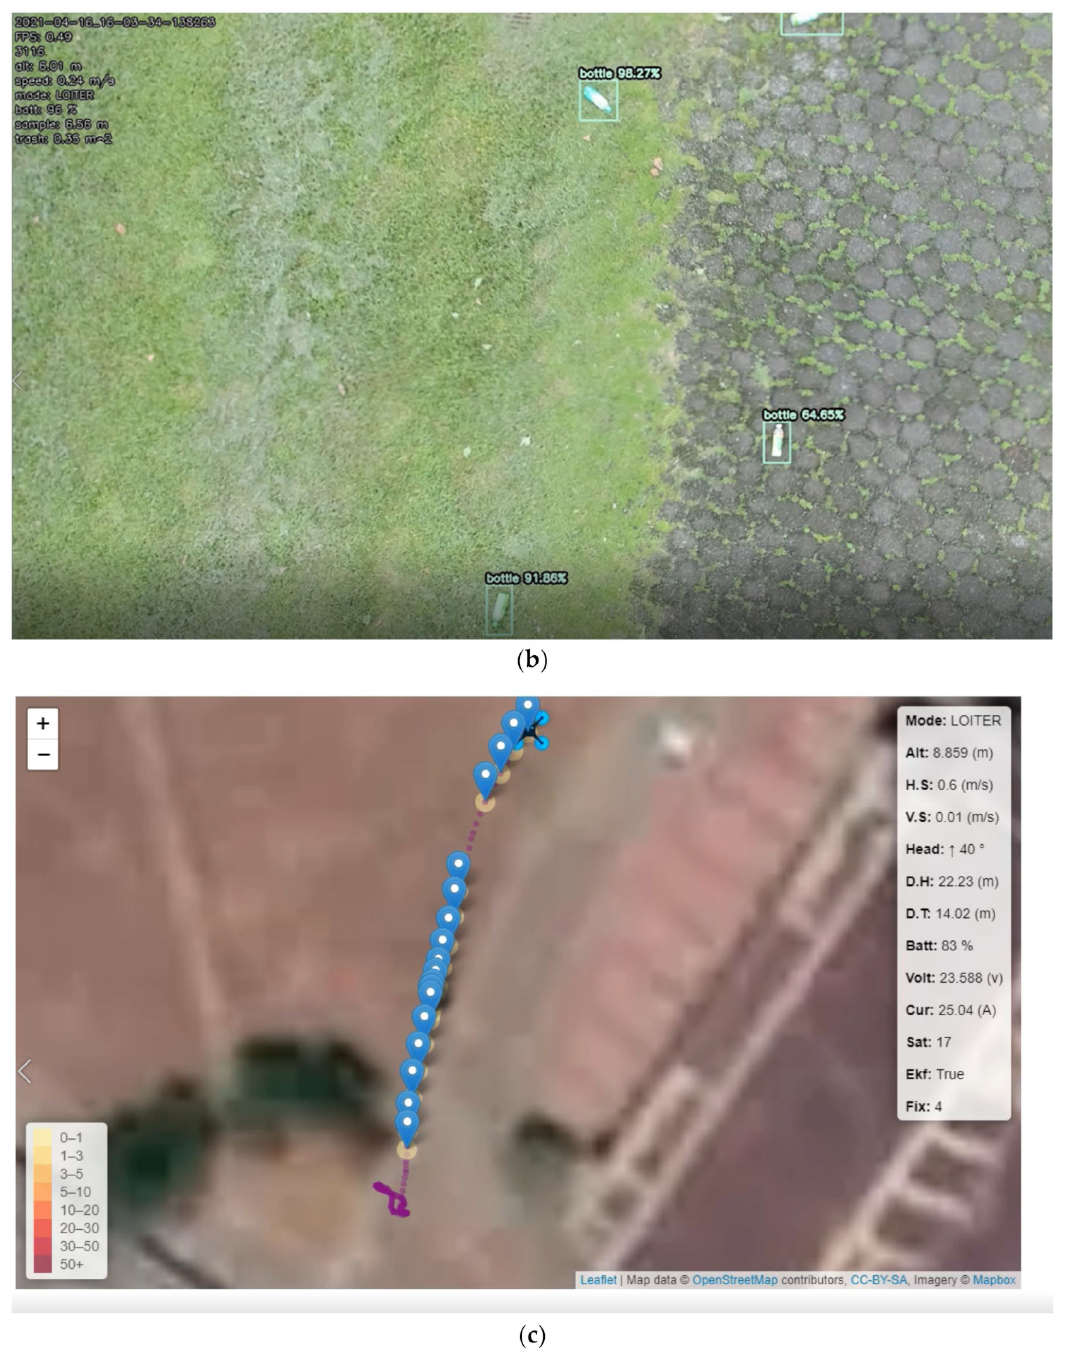
Figure 13. The result of the unmanned aerial vehicle (UAV) trash monitoring system in NTOU campus. ( a ) An area with the UAV and trash. ( b ) Video streaming server: detection result sent by the UAV. ( c ) UAV map: real-time monitoring by the UAV and the detection